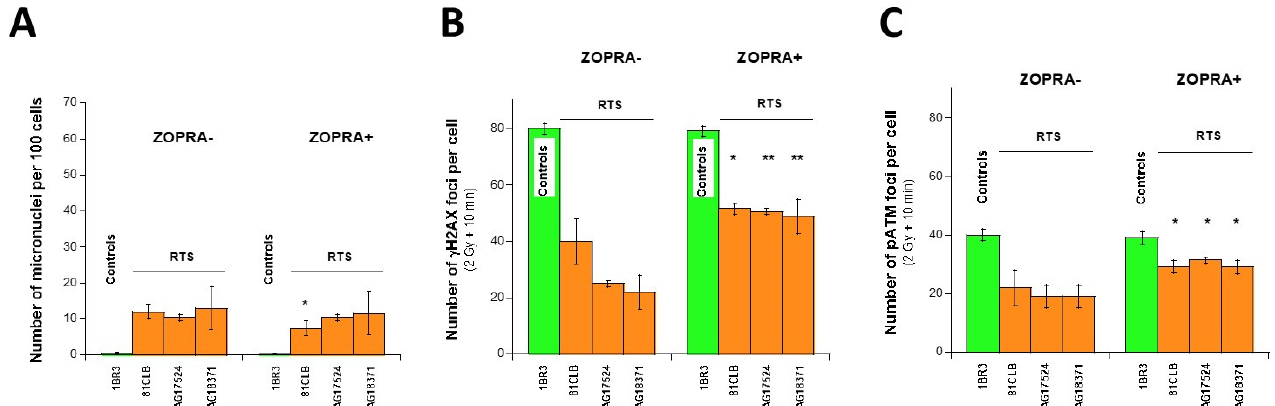
Figure 9. Effect of ZOPRA treatment on RTS fibroblasts. Numbers of micronuclei per 100 cells assessed after 2 Gy followed by 24 h post-irradiation ( A ), numbers of γ H2AX foci per cell assessed after 2 Gy followed by 10 min post-irradiation ( B ), numbers of pATM foci per cell assessed after 2 Gy followed by 10 min post-irradiation ( C ) in the indicated control and RTS fibroblasts with or without ZOPRA treatment. Data plots represent the mean ± SEM of duplicate experiments. Asterisks represent the statistical differences with untreated cells expressed as p -value (1 and 2 asterisks correspond to p < 0.05 and p < 0.01, respectively).